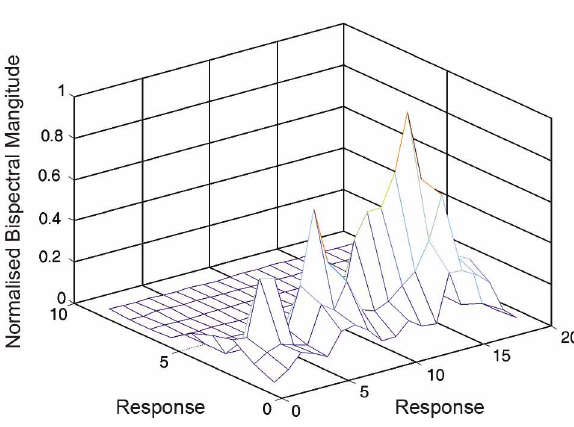
Fig. 4. Bispectrum of importance of project